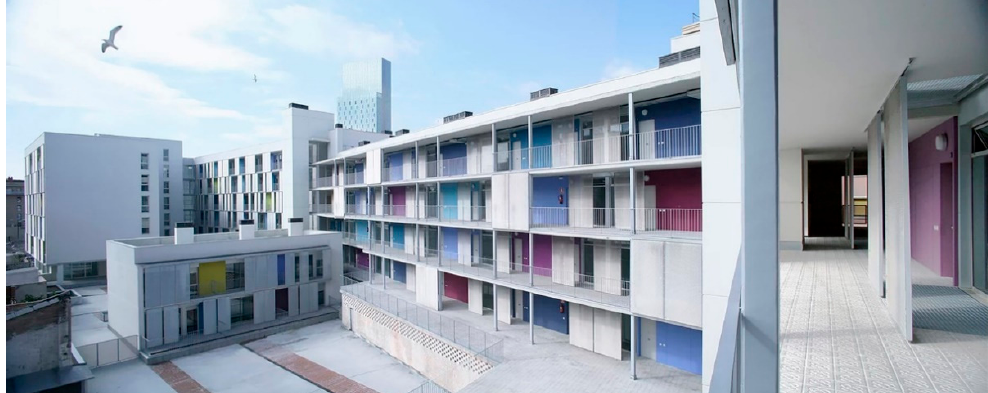
Figure 6. Social housing complex for elderly and young people, Barcelona, Spain, by Renau Bartumeus. © 2016 by renau bartumeus arquitectes.